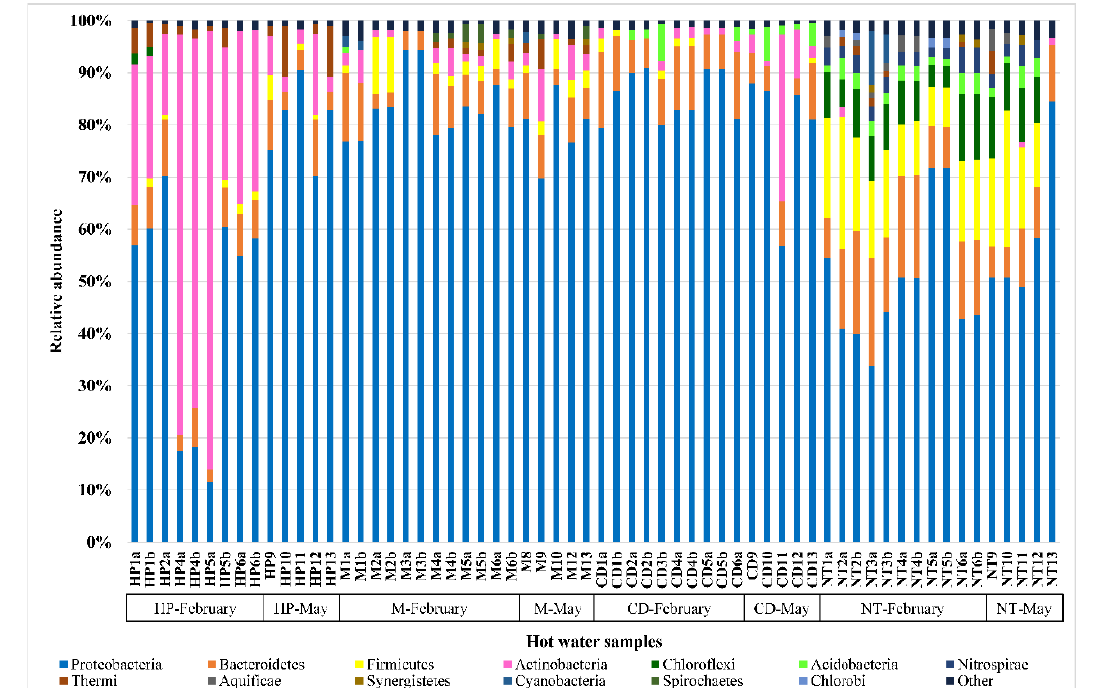
Figure 3. Distribution of phyla in hot water samples (cut off 1%). Phyla with relative abundance ≤1% are included in "other". HP: network with hydrogen peroxide, M: network with monochloramine, CD: network with chlorine dioxide, and NT: not chemically treated network.